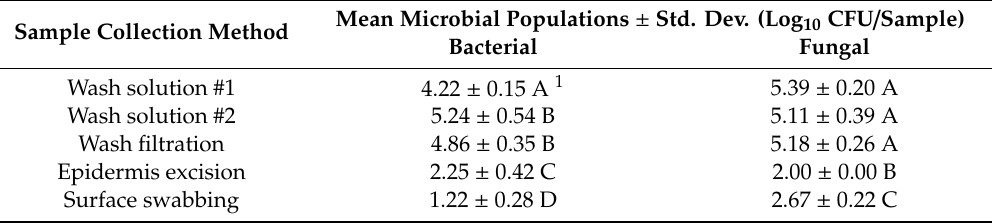
Table 3. Mean culturable bacterial and fungal populations by sample collection method.